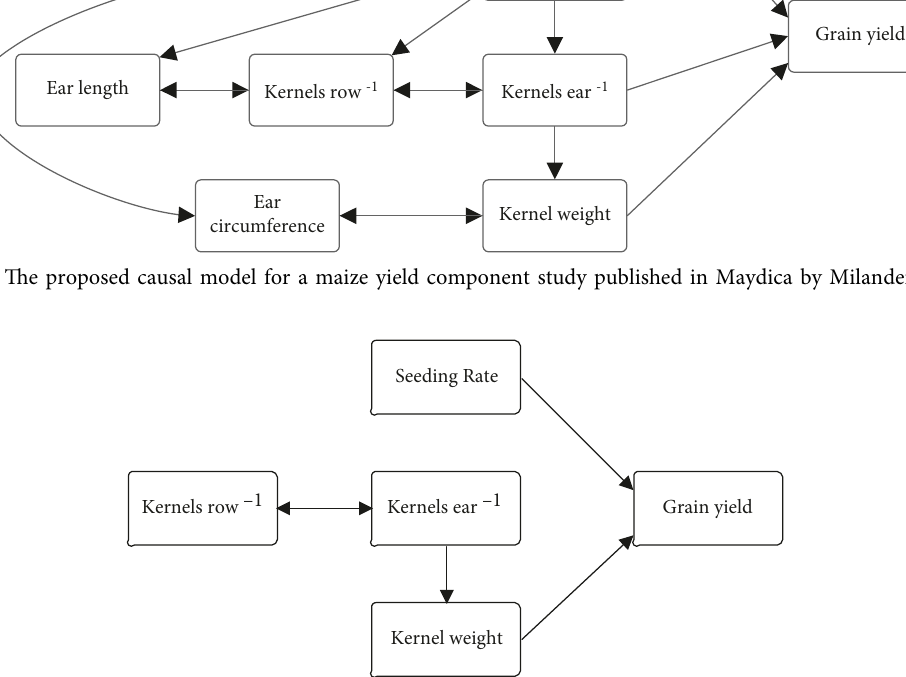
Figure 2: The data-supported causal model for the maize yield component study published in Maydica by Milander et al.